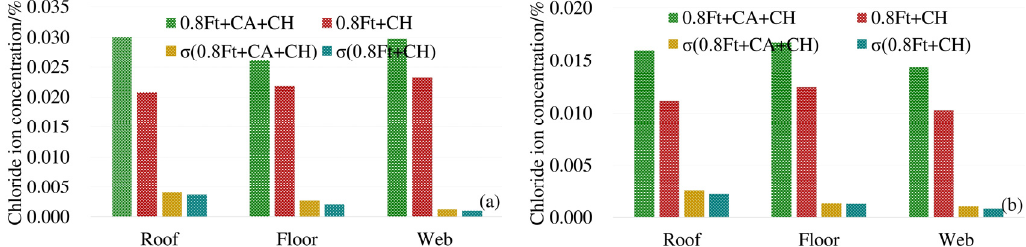
Figure 5. Average chloride concentration at different positions from the box girder surface: ( a ) 4 mm from the box girder surface; ( b ) 7 mm from the box girder surface.